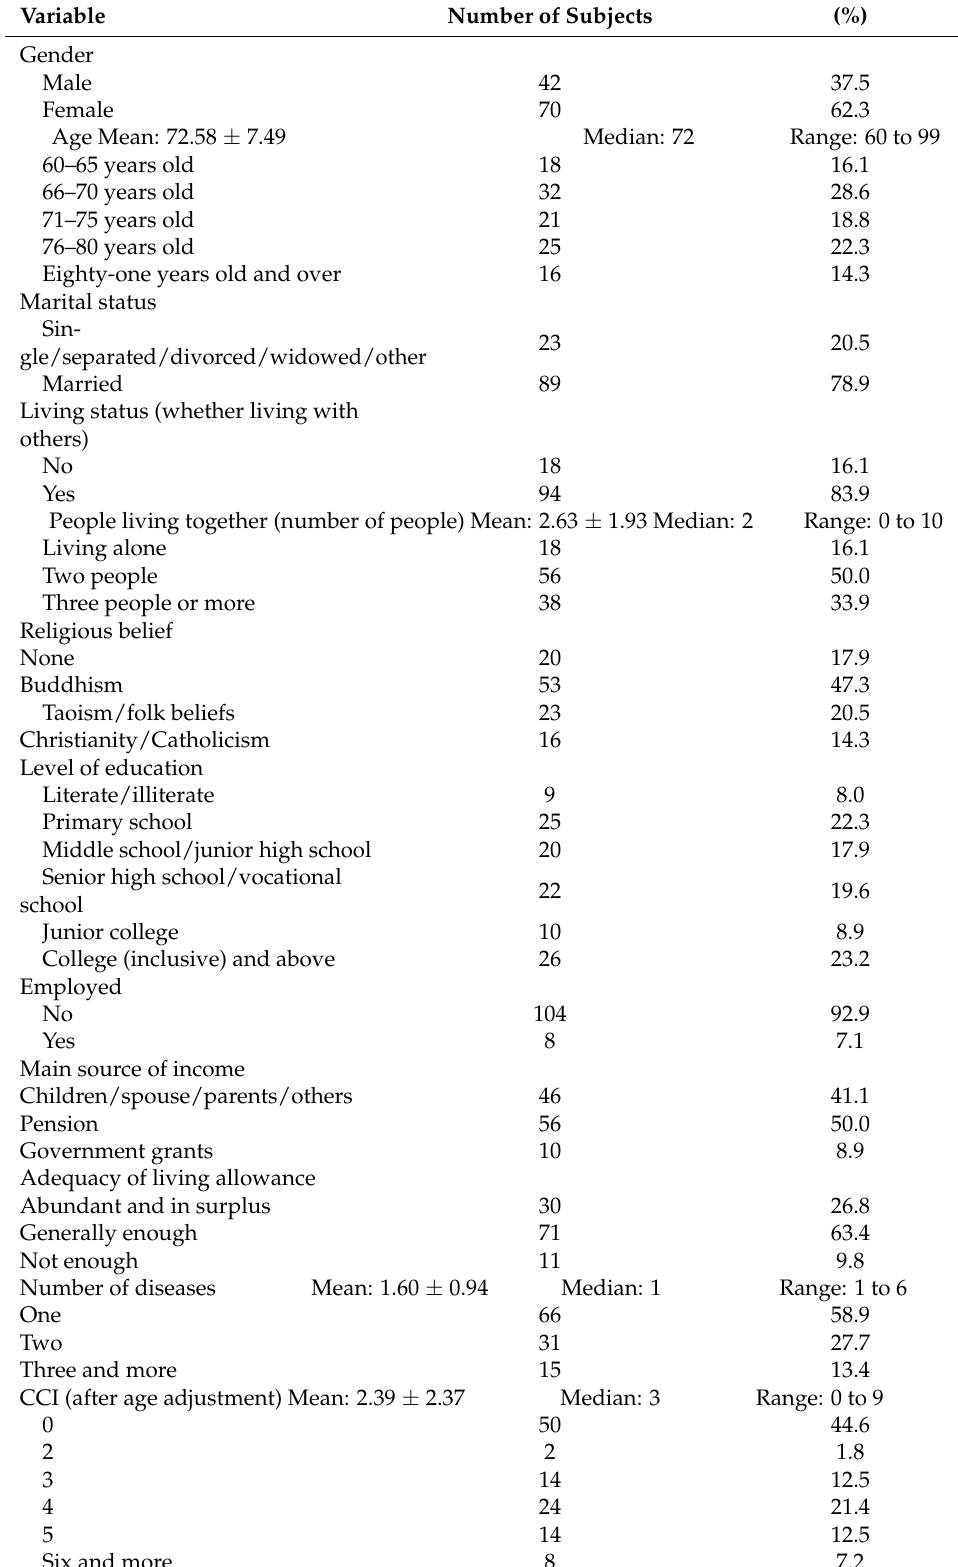
Table 1. Demographic characteristics of participants ( n =